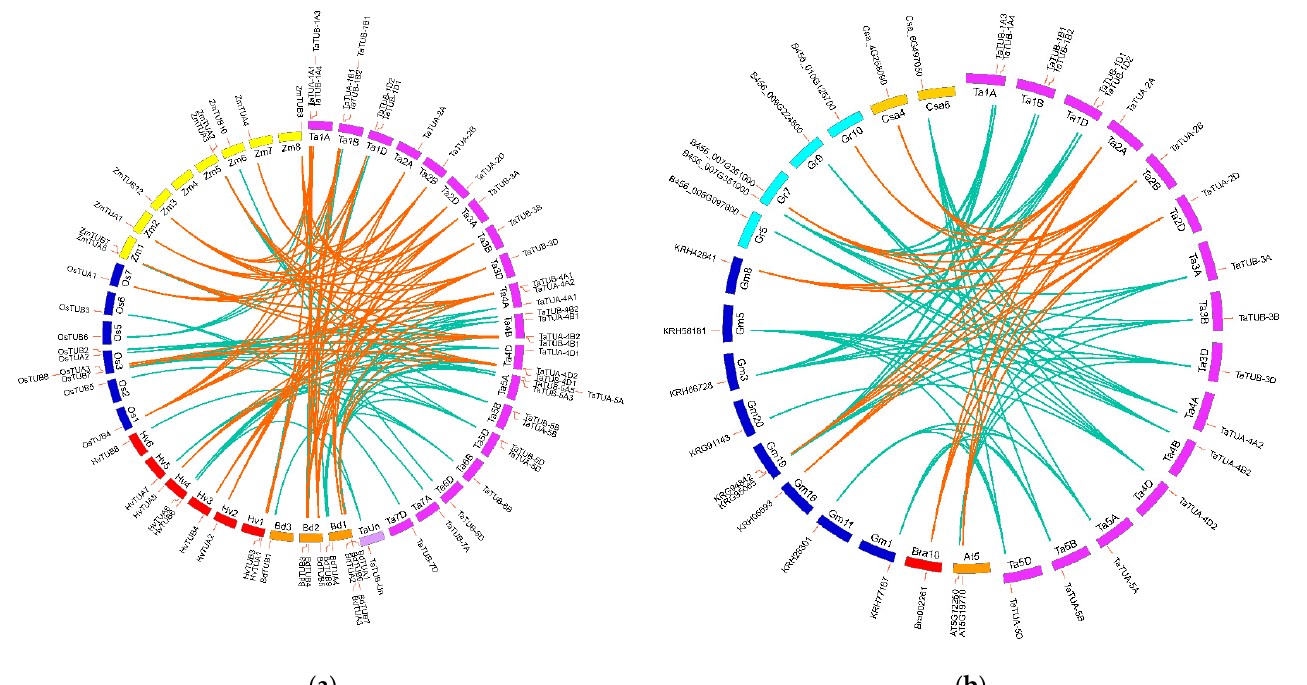
Figure 2. Synteny of TaTUA and TaTUB genes in wheat with other plant species: ( a ) wheat and four monocot plant species; ( b ) wheat and five dicot plant species. Colored lines link syntenic relationships of the TUA and TUB genes.